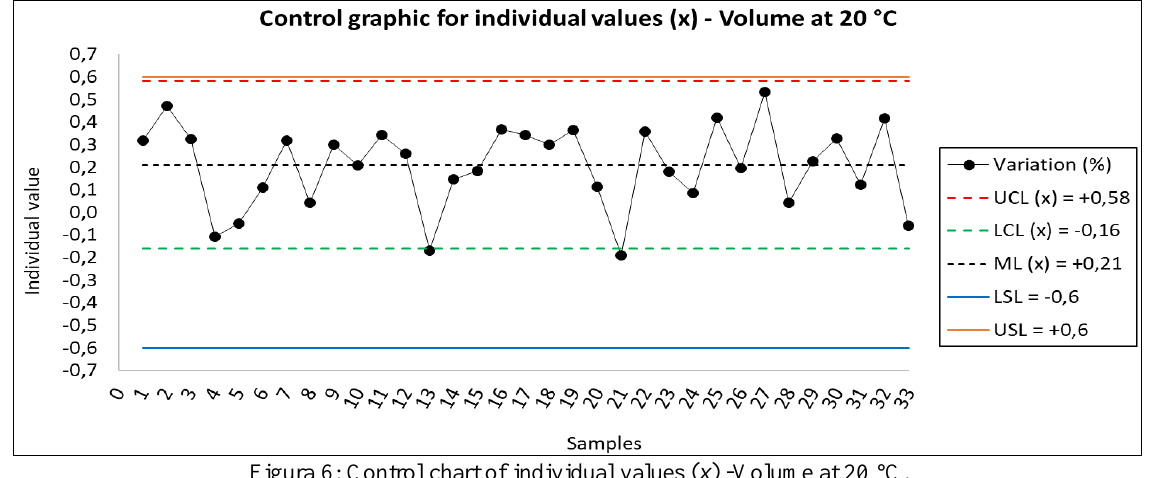
Figura 6: Control chart of individual values ( x ) -Volume at 20 °C.